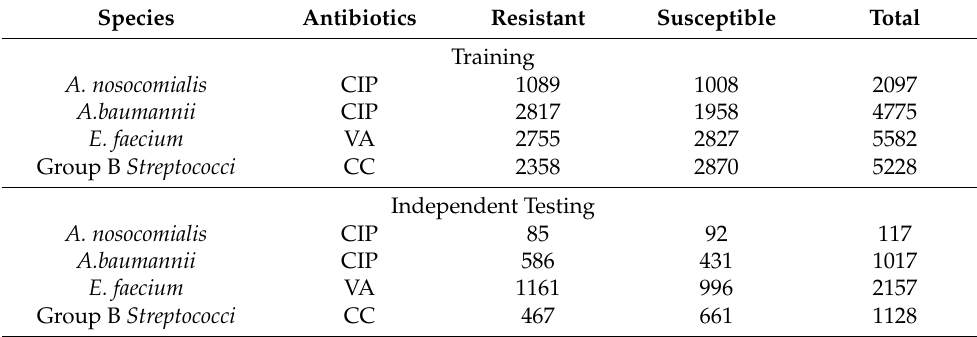
Table 3. Statistics of antibiotic resistance in training and independent testing